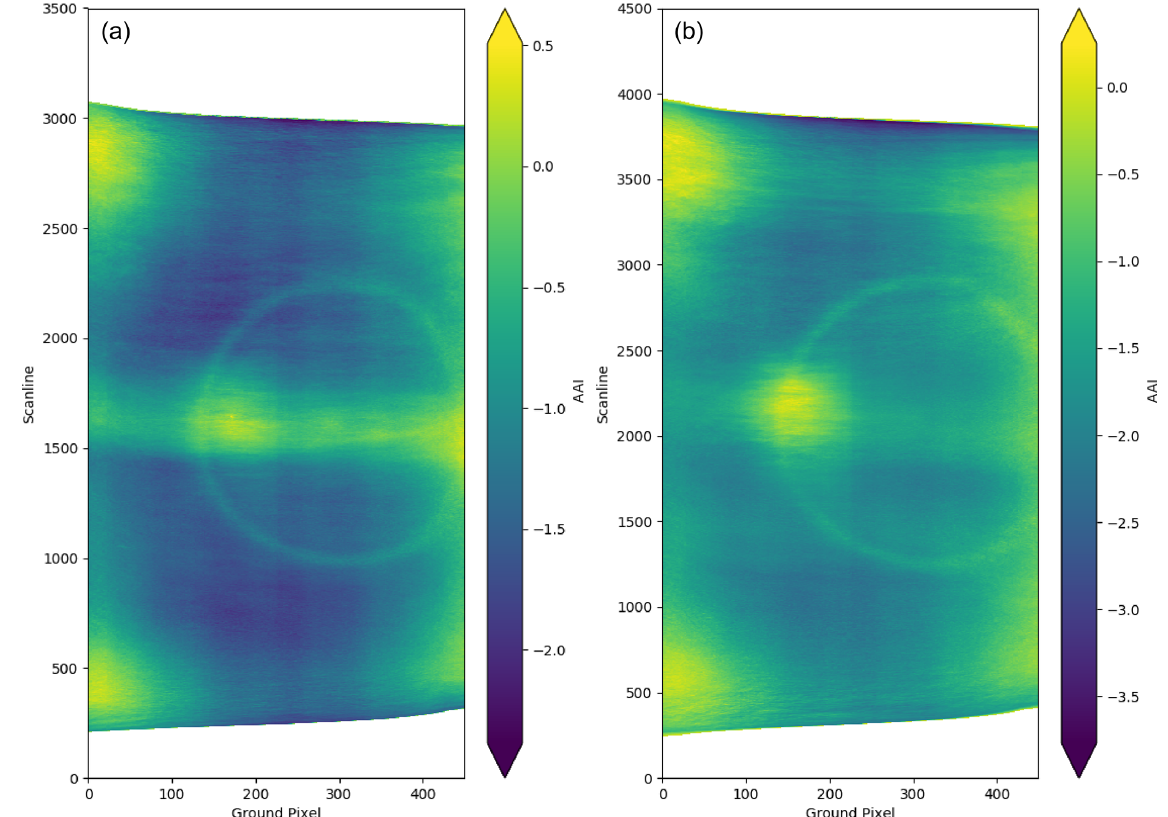
Figure 3. Orbital distribution of the TROPOMI AAI averaged over multiple orbits, for global data ( a ; 103 orbits) and data over the Pacific ( b ; 54 orbits) in August 2019. The x -axis “groundpixel” represents the viewing direction, whereas the y -axis “scanline” represents the solar position. The contribution of Saharan dust plumes can clearly be seen as a band in the center of the orbit. The Pacific is mostly devoid of absorbing aerosols, and therefore the AAI only shows non-aerosol effects. Note the different color